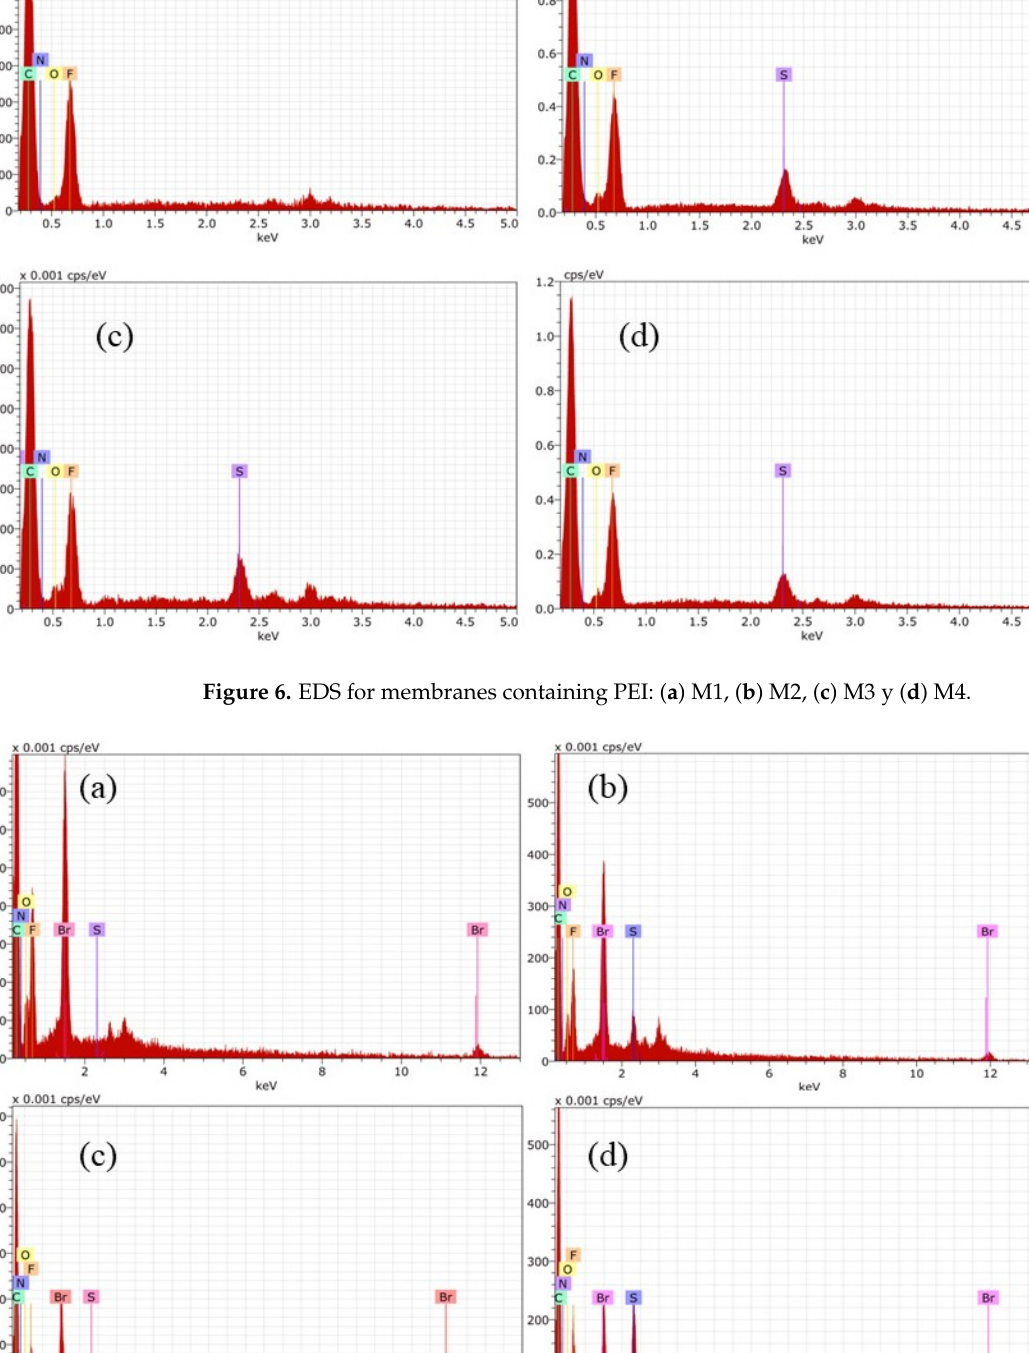
Figure 7. EDS for Fumion ® -based membranes: ( a ) F1, ( b ) F2, ( c ) F3 y ( d ) F4.